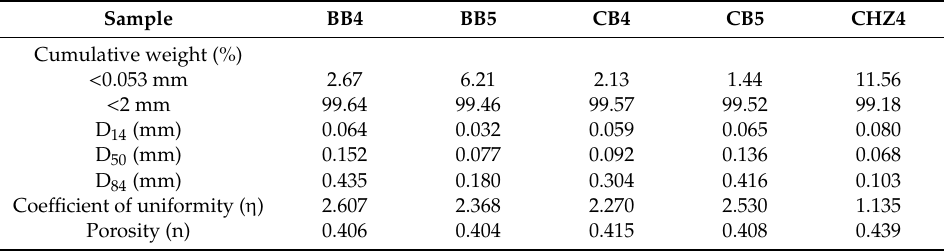
Table 4. Sediment size distribution about the confluence, reporting the cumulative weight (%) for the two size fractions of sand and finer than sand, the particle diameter (mm) for 14%, 50%, and 84% finer than the diameter, coe ffi cient of uniformity, and